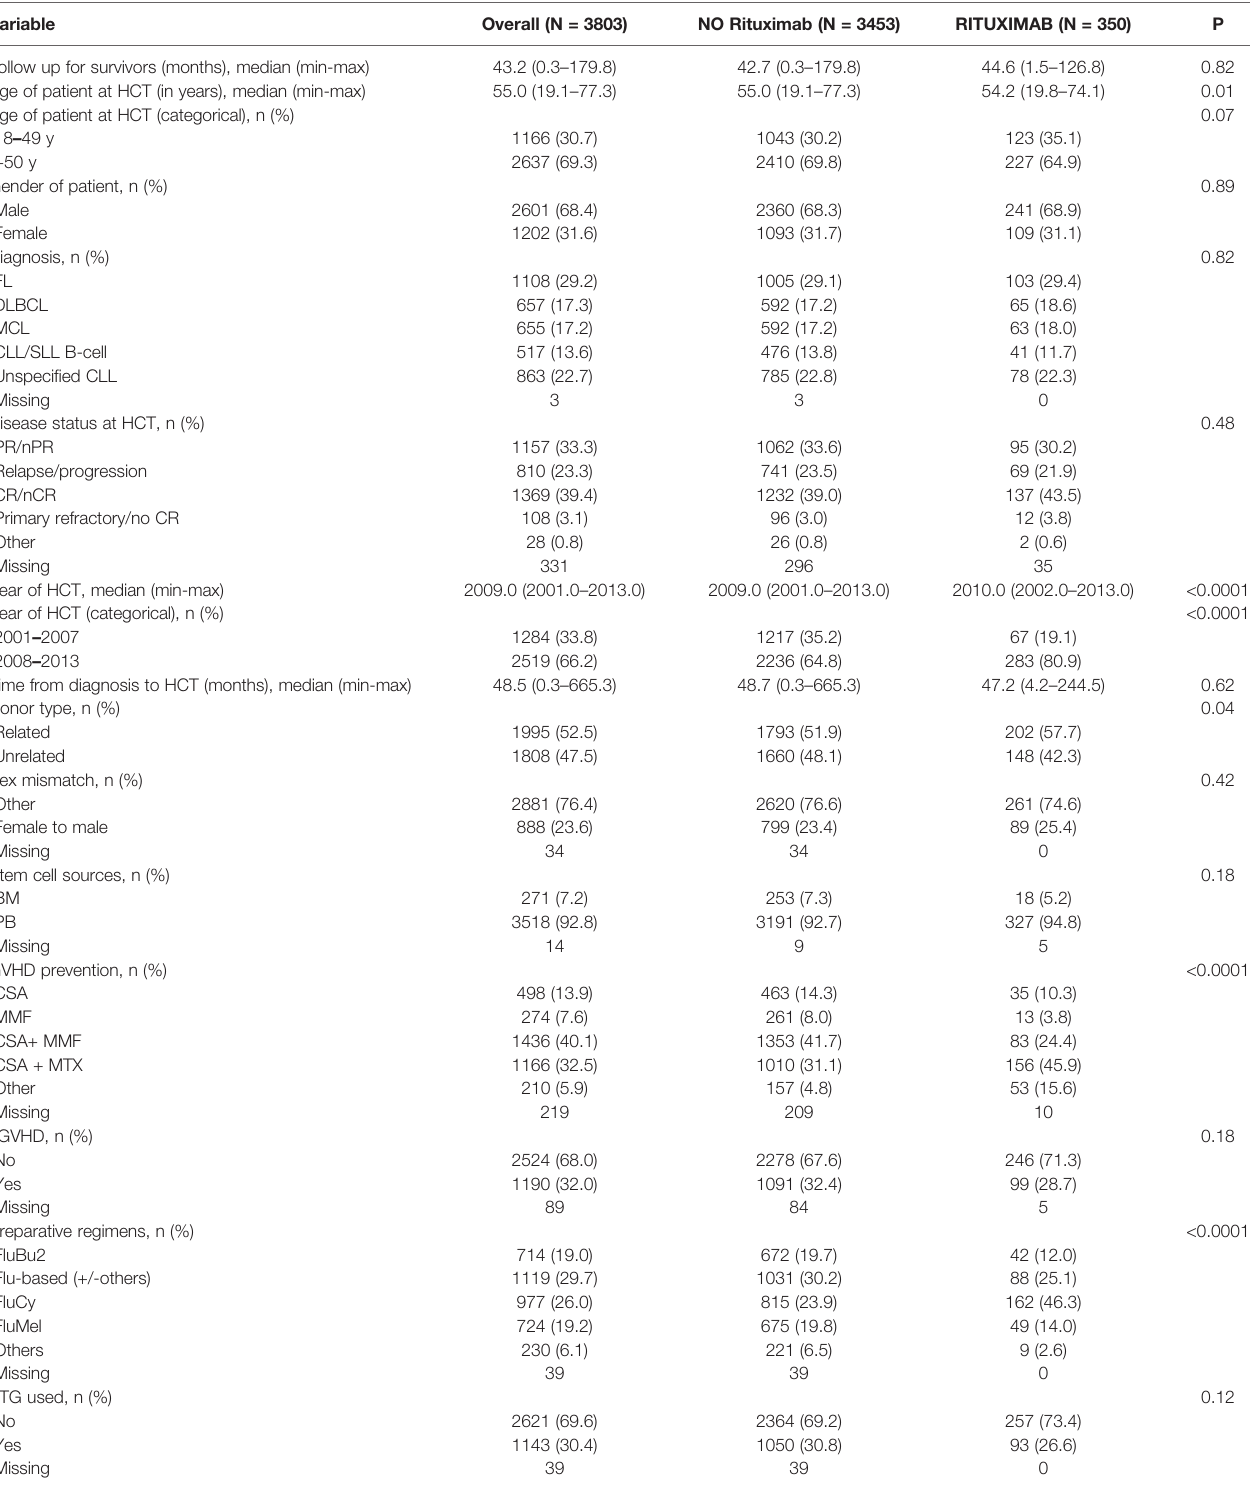
TABLE 1 | Pre-transplant and transplant characteristics.